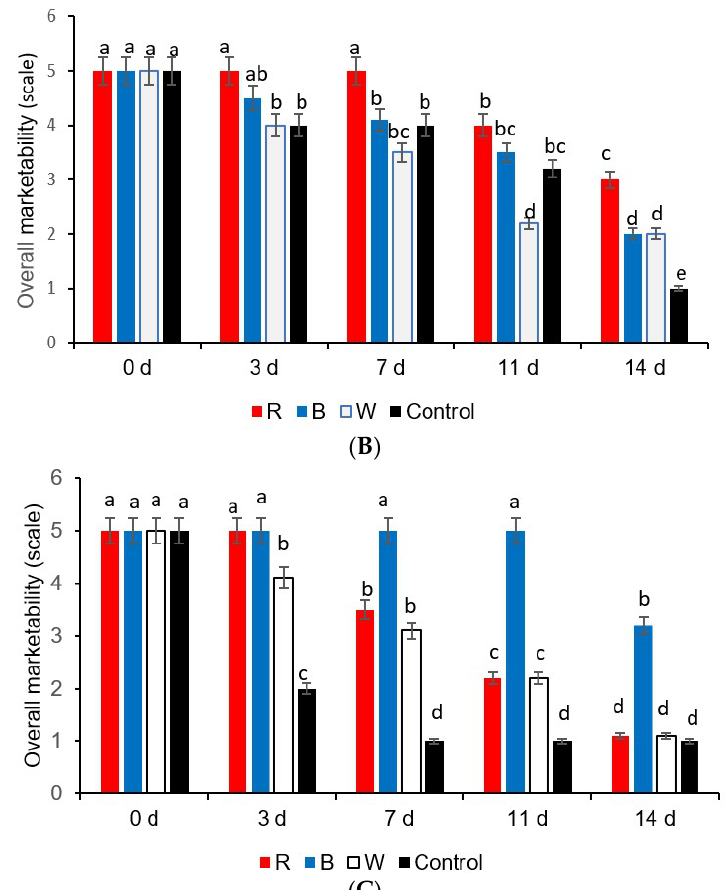
Figure 2. Overall marketability of ( A ) yellow, ( B ) green, and ( C ) red sweet pepper fresh-cuts exposed to LED light treatments. Where 5 = highly marketable and 0 = unmarketable. R—Red, B—Blue, W—White light; Control—Darkness. Data include 0, 3, 7, 11, and 14 days storage time. Different letters above each bar indicate significant differences ( p < 0.05) using Fisher’s LSD test.